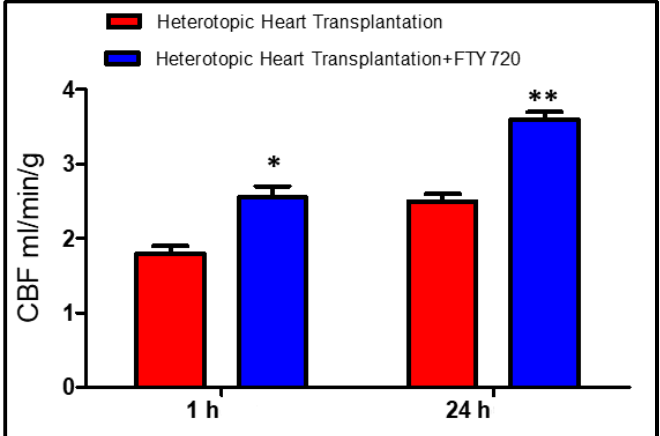
Figure 2. Coronary blood flow (CBF) measurements. Group A, B: early reperfusion at 1 h, Group C, D: late reperfusion at 24 h of reperfusion. * p < 0.05, ** p < 0.001.